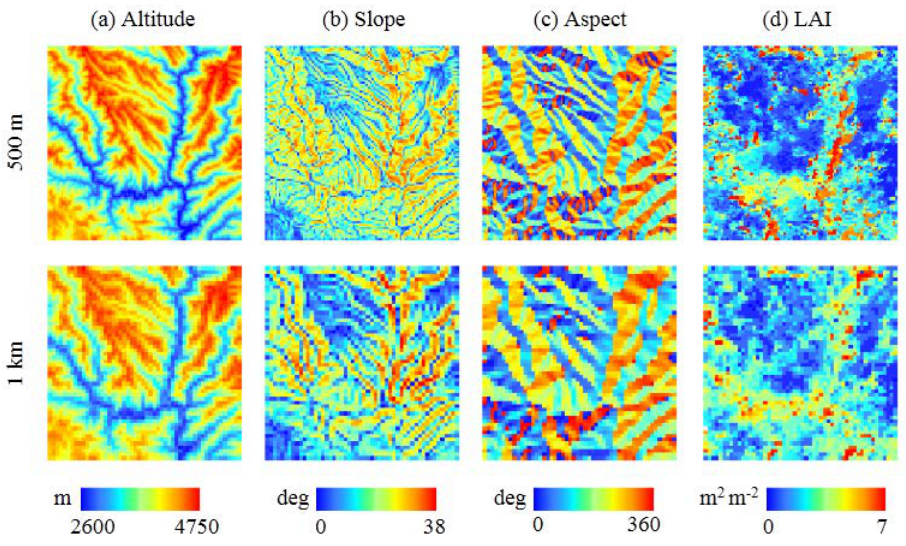
Figure 3. Spatial distributions of altitude ( a ); slope ( b ); aspect ( c ) and LAI ( d ) at 500 m and 1 km.